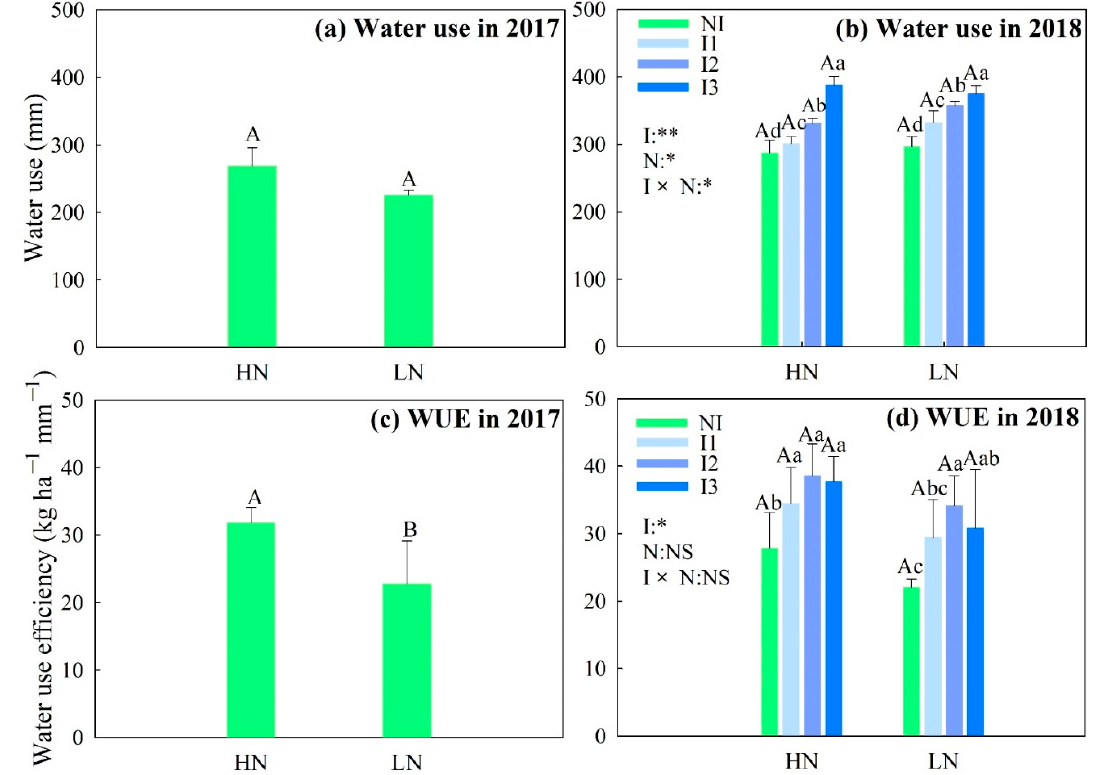
Figure 3. Water use ( a , b ) and water use efficiency ( c , d ) of oat under different irrigation and nitrogen fertilizer treatments in 2017 ( a , c ) and 2018 ( b , d ). HN—high nitrogen; LN—low nitrogen; NI—no irrigation; I1—irrigation only at flowering; I2—irrigation at tillering and jointing; I3—irrigation at tillering, jointing, and flowering. Different capital letters indicate a significant difference between different nitrogen treatments, and different lowercase letters indicate significant differences among different irrigation treatments under the same nitrogen level ( p < 0.05). I—irrigation; N—nitrogen; I × N—irrigation × nitrogen. One star and two stars mean that the effect is significant at p < 0.05 and p < 0.01 levels, respectively, and NS means the effect is insignificant. Error bars indicate one standard deviation from the mean.